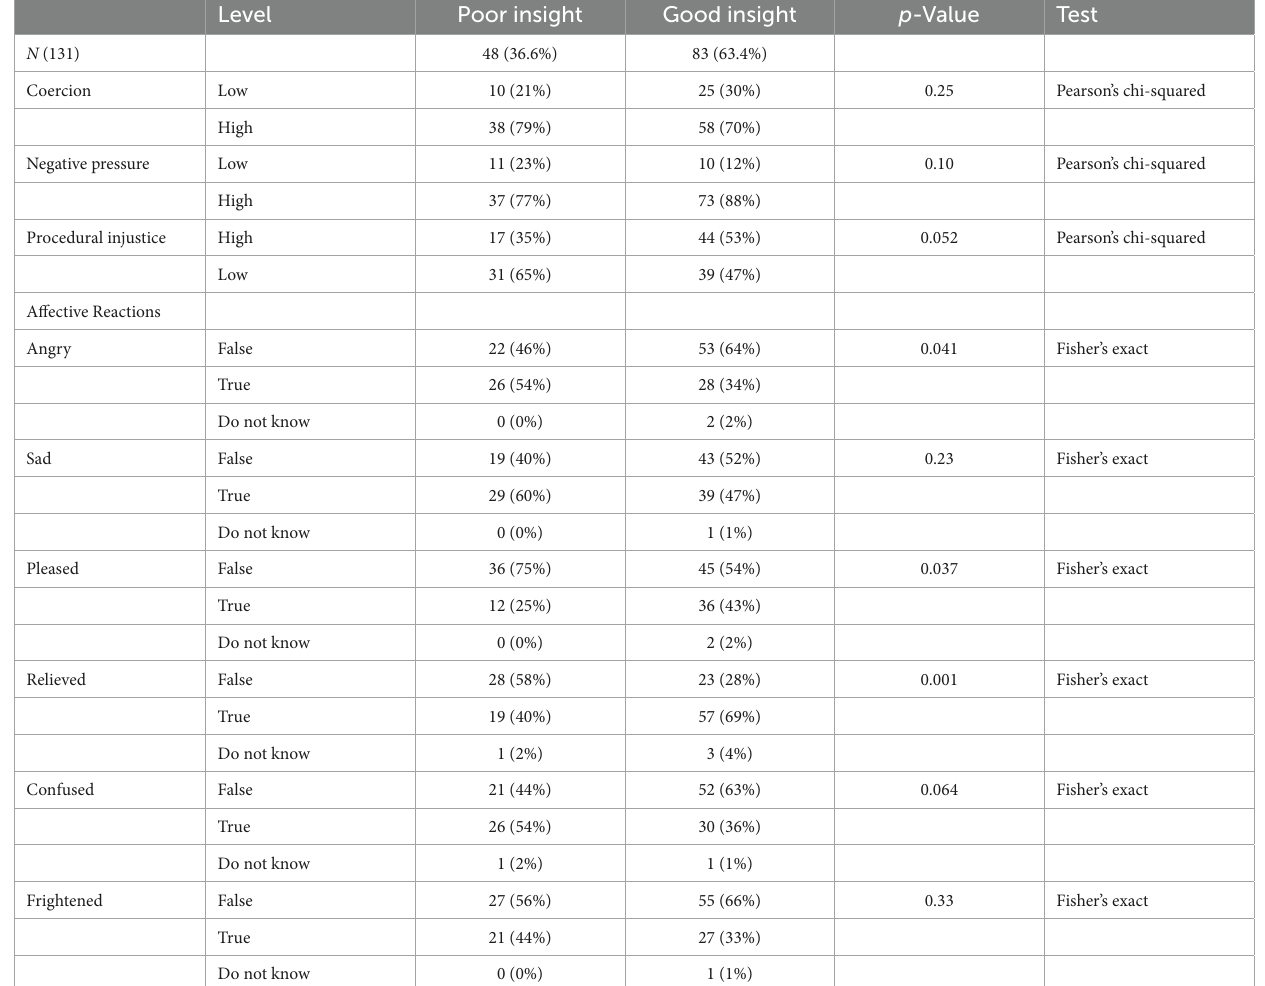
TABLE 4 The associations between levels of insight and the